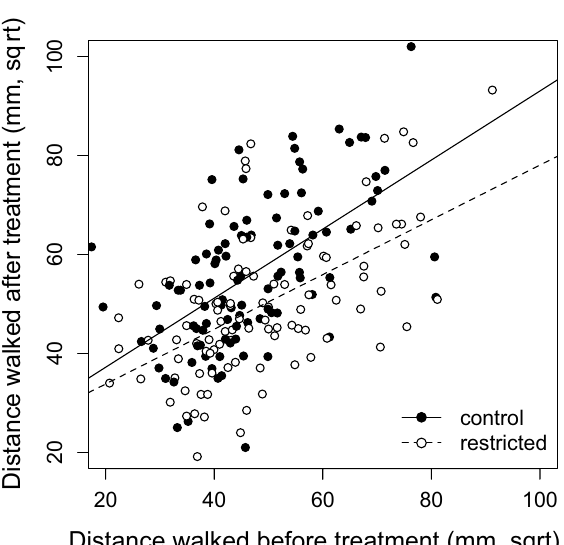
Figure 3. Long-term experiment: movement activity (after square-root transformation) assessed before and after the experimental treatment in the two experimental groups (restricted and